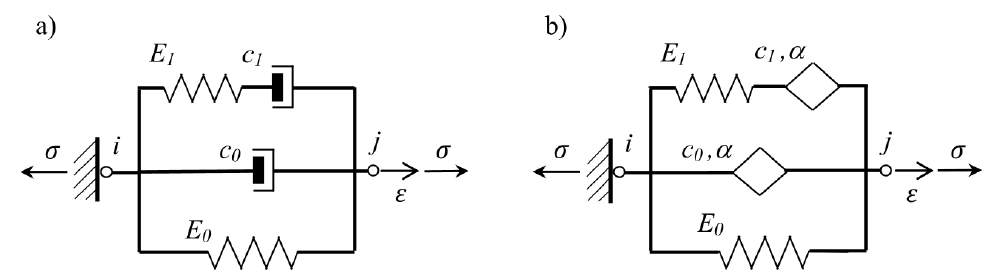
Figure 2. Complex models of VE material: ( a ) classical, and ( b )